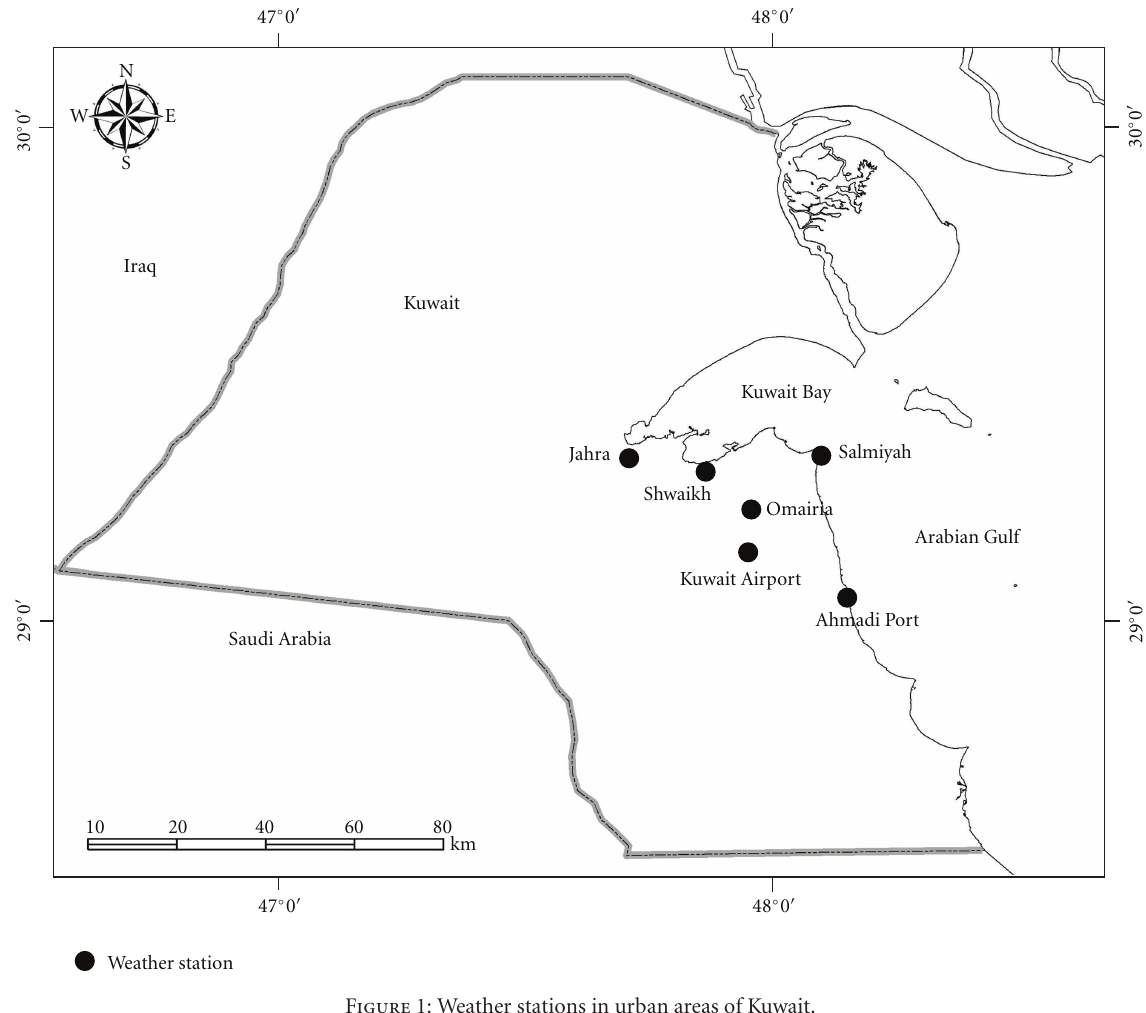
Figure 1: Weather stations in urban areas of Kuwait.